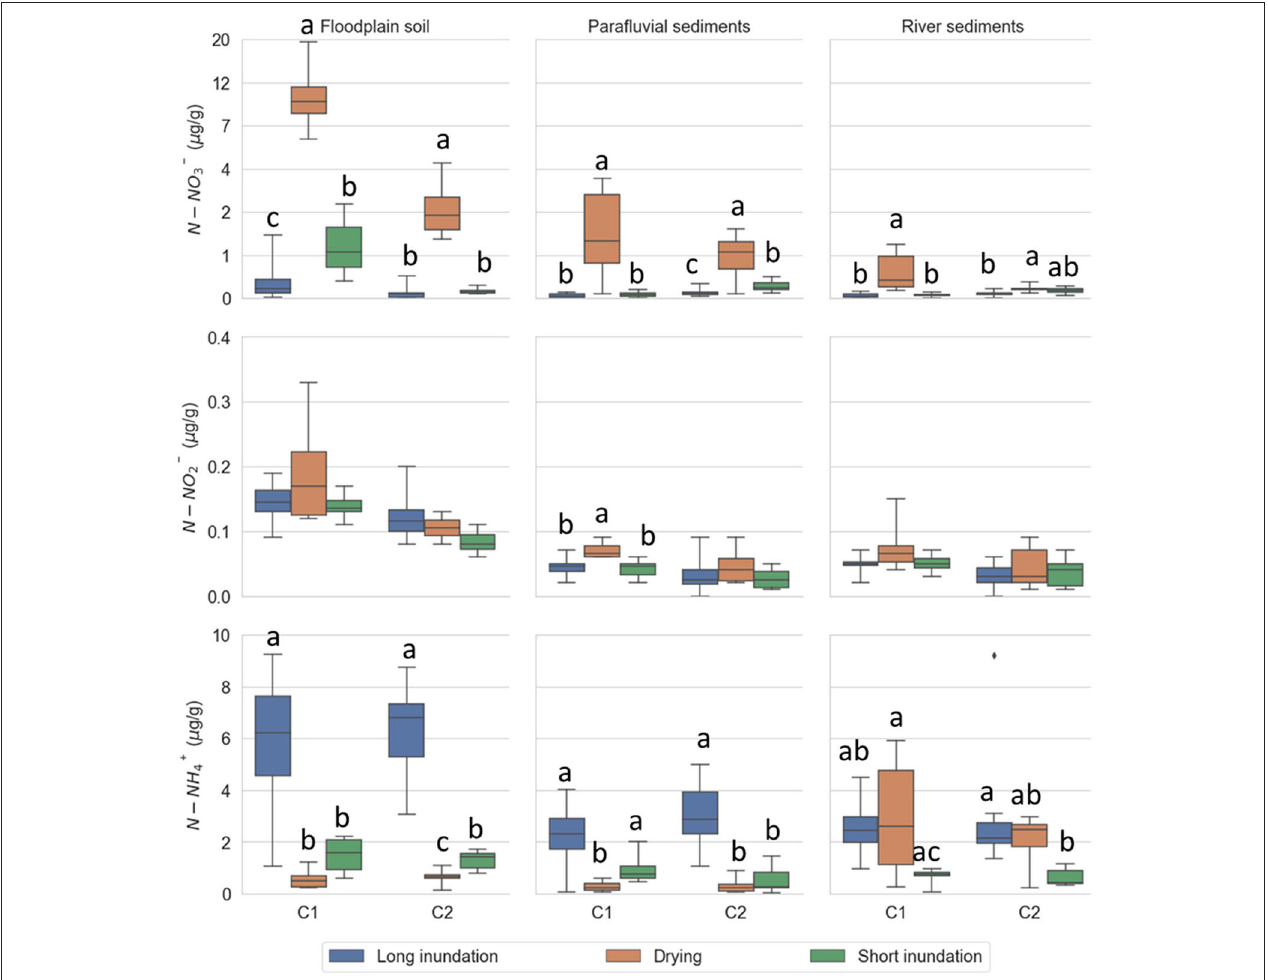
FIGURE 3 | Mineral N content in soil and sediment extracts per site (floodplain soil, parafluvial sediments, river sediments) for each phase (long inundation, drying phase, short inundation phase). The data is aggregated by cycle (cycle 1 and 2). For each cycle, the treatment cores were subject to drying (orange; n = 6) and short inundation (green; n = 6) events. The control cores (blue; n = 12) were kept flooded throughout the entire experiment and were equally sampled at the same dates as the treatment cores. Nitrate content was pseudo log transformed for better visibility of range. Error bars are the 95% confidence interval, the bottom and top of the box are the 25th and 75th percentiles, the line inside the box is the 50 th percentile (median), and any outliers are shown as